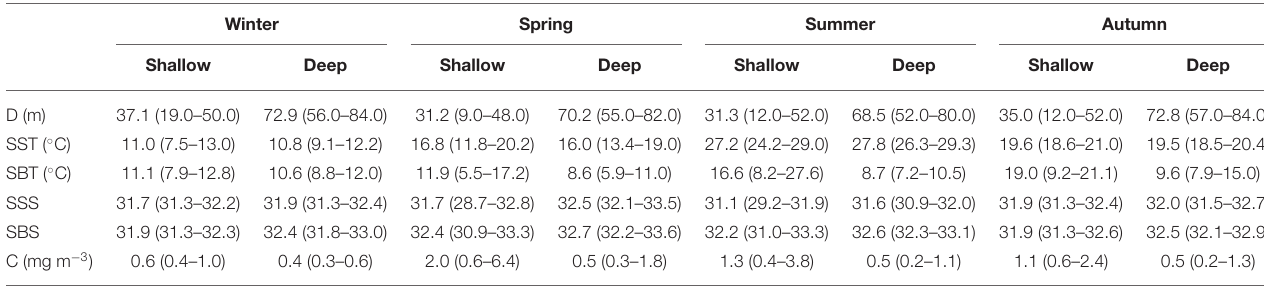
TABLE 1 | Seasonal changes in environmental factors (mean and range) in the two domains in the Yellow Sea. Winter Spring Summer Autumn Shallow Deep Shallow Deep Shallow Deep Shallow